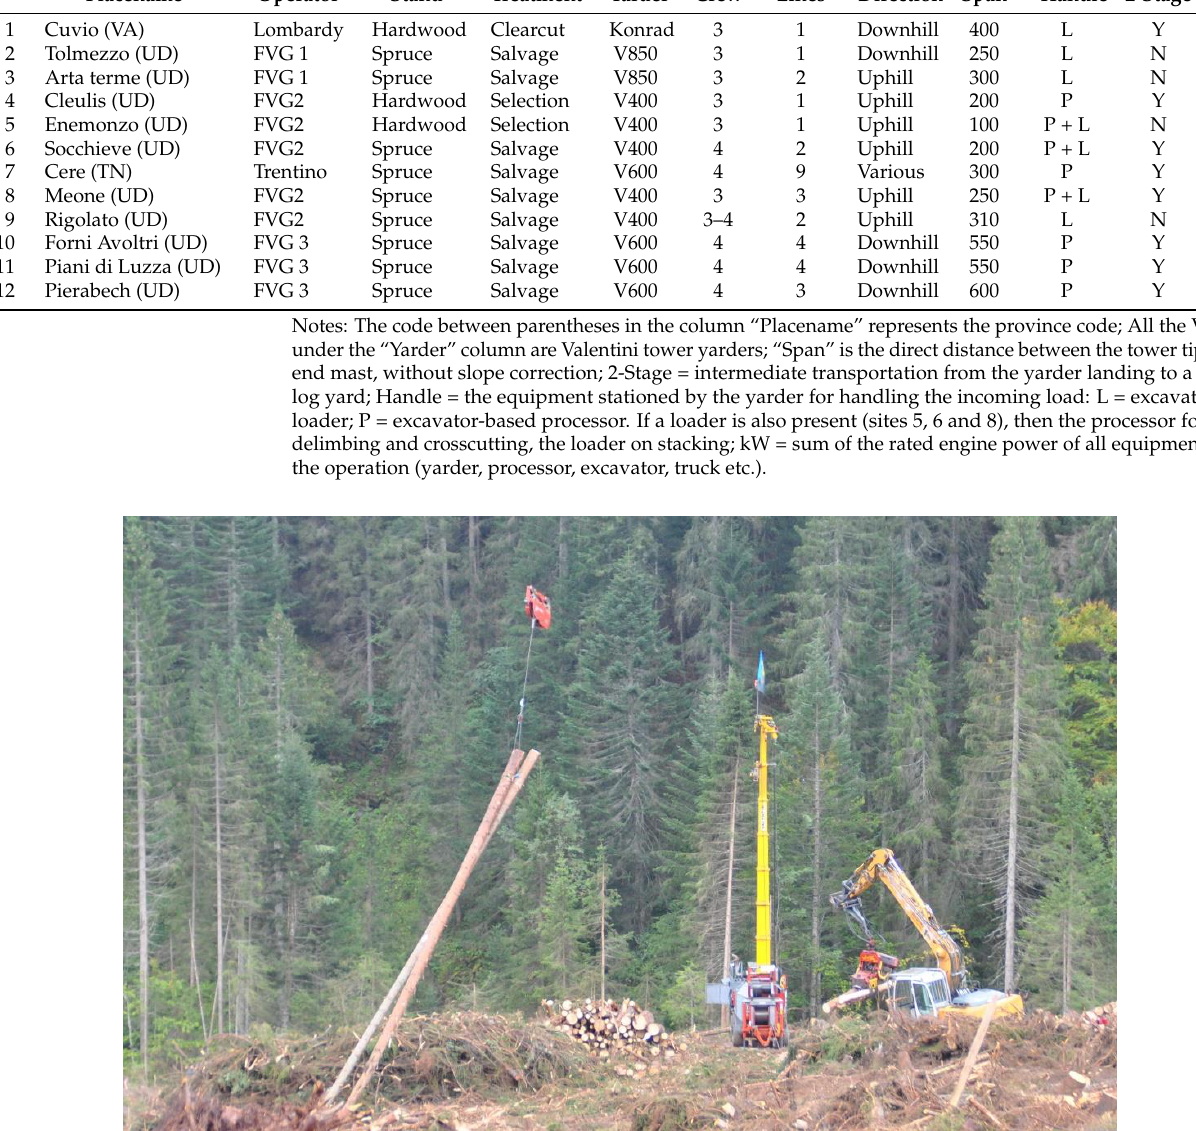
Table 1. Description of the test operations.